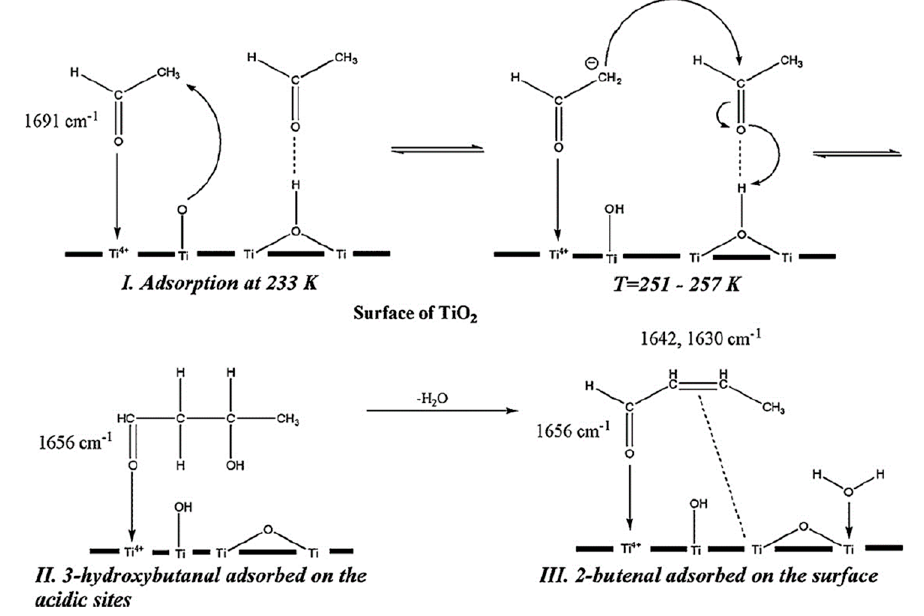
Figure 4. The schematic diagram of the proposed mechanism for the aldol condensation of acetaldehyde on TiO 2 surface. Reprinted from [19], Copyright 2020, with permission from Elsevier.